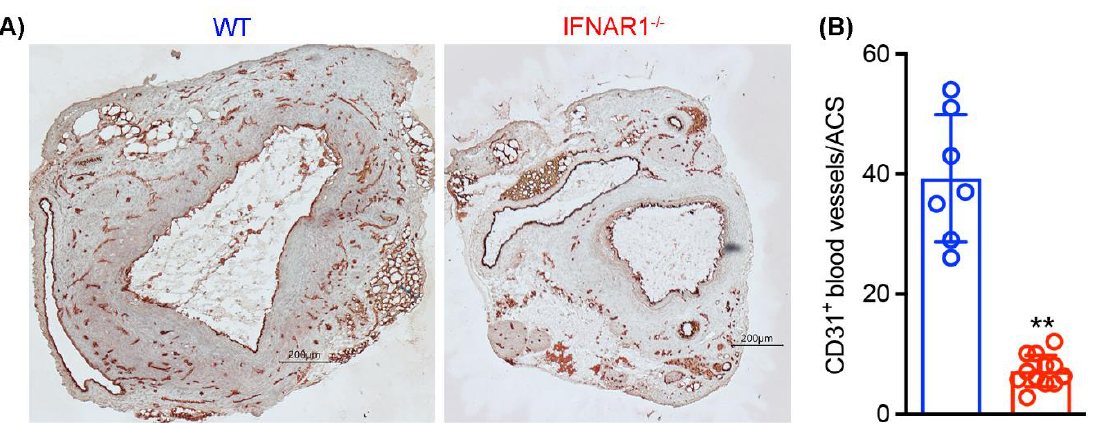
Figure 6. Type I IFN receptor subunit 1 deficiency is protective against mural angiogenesis in experimental AAAs. Aortic frozen sections from elastase-infused wild type (WT, n = 7) and type I IFN receptor subunit 1-deficient (IFNAR1 −/− , n = 12) mice were stained with an anti-mouse CD31 monoclonal antibody to identify neovessels. ( A ) Representative CD31 immunohistochemical images for neoangiogenesis in AAAs from WT and IFNAR1 −/− mice. ( B ) Mean and standard deviation of mural neoangiogenesis quantified as the number of CD31-positive vessels per aortic cross-section (ACS). Student t’s test, ** p < 0.01 compared to WT mice. Scale bar: 200 μ m.